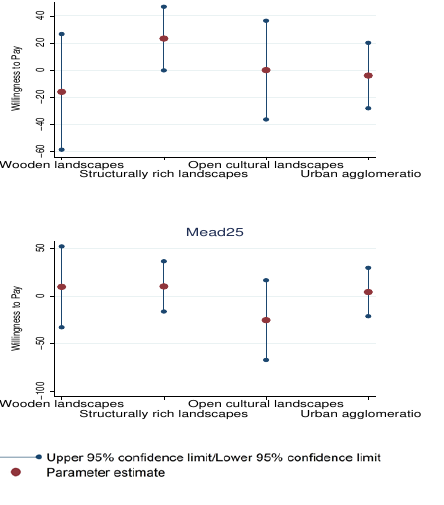
Figure 3: willingness to pay CI by